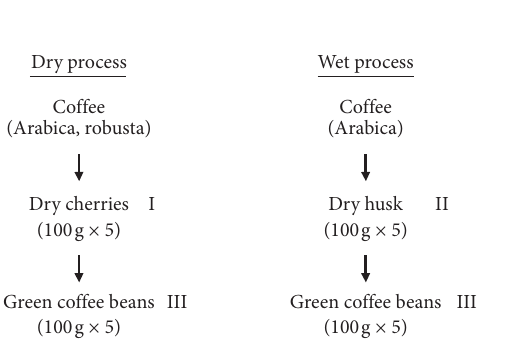
Figure 1: Short coffee processing steps in Cameroon. I, II, and III: sampling